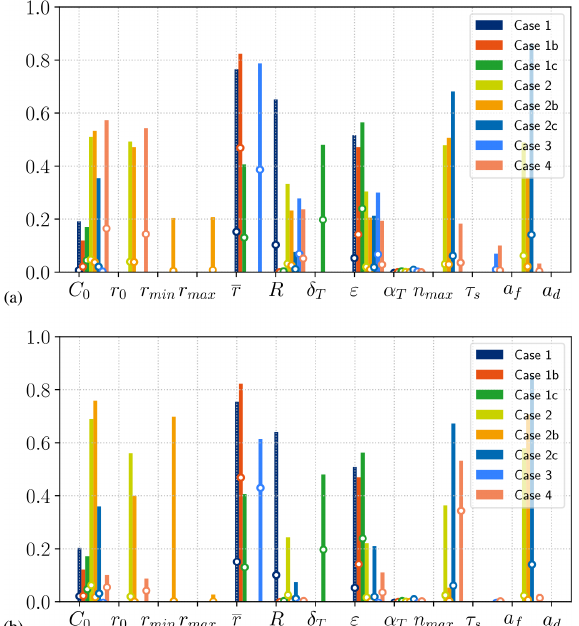
Figure E1. Aggregated first-order Sobol indices (dots) and aggregated total Sobol indices (bars) for temperature (a) and total frazil volume fraction (b) for case 1, 1b, 1c, 2, 2b, 2c, 3 and